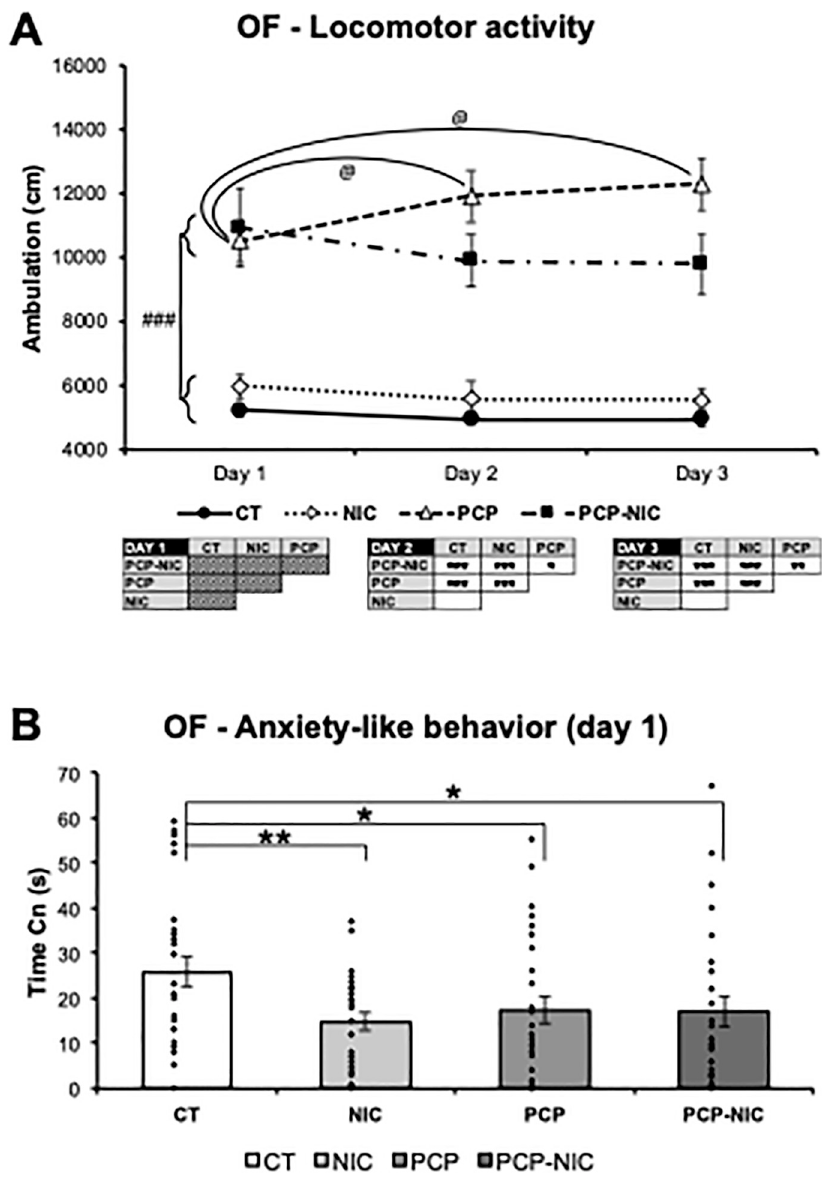
Fig 2. Effects of phencyclidine treatment, nicotine history and the combined insults on adolescent mice, as assessed in the open field arena: (A) locomotor activity and (B) anxiety-like behavior. CT: Control group ( ♀ = 12, ♂ = 16); NIC: Nicotine-exposed group ( ♀ = 14, ♂ = 14); PCP: Phencyclidine-treated group ( ♀ = 14, ♂ = 14); PCP-NIC: Phencyclidine-treated and nicotine-exposed group ( ♀ = 12, ♂ = 14). Values are means ± SEM. � p < 0.05, �� p < 0.01, ��� p < 0.001. @ p < 0.05, Day 1 vs . Day 2 or Day 1 vs . Day 3 within each experimental group. ### p < 0.001, phencyclidine-treated (PCP and PCP-NIC) vs . phencyclidine non-treated (CT and NIC) mice. phencyclidine-treated mice (PCP and PCP-NIC) when compared to non-treated ones (CT and NIC) (Test session: Phencyclidine–F = 6.0, p = 0.017). The negative impact of phency- 1,53 clidine on memory was further confirmed by paired t-tests: While both CT ( p = 0.011) and NIC ( p < 0.001) males increased the preference for the new object when the training and the test sessions were compared, there were no differences between sessions for PCP and PCP-NIC ones (Fig 3B).